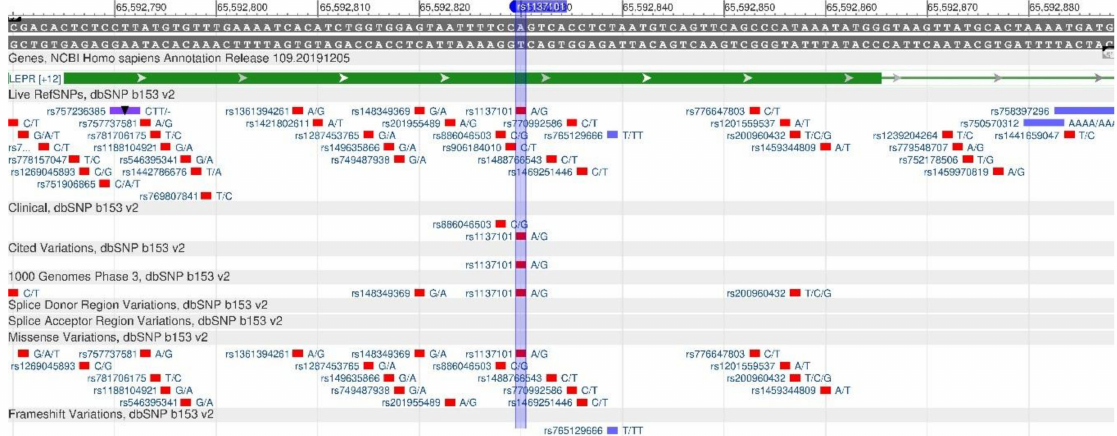
Figure 11. A portion of the LEPR gene (located on the short (p) arm of chromosome 1) containing the oligonucleotide polymorphism